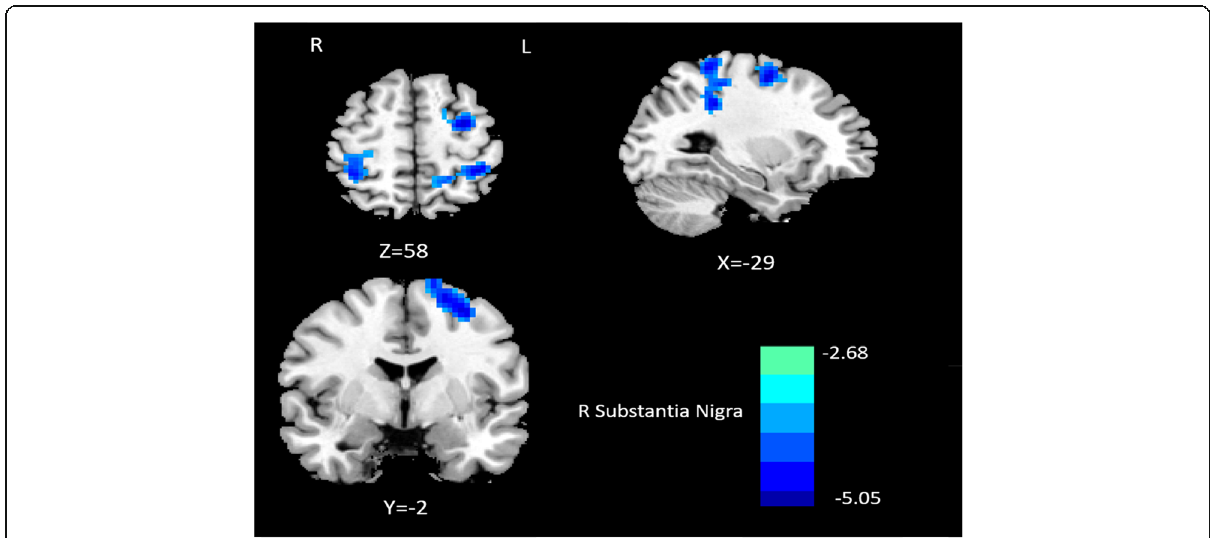
Fig. 2 Altered effective functional connectivity between the right substantia nigra and whole-brain regions in patients with migraine without aura compared with healthy controls. Blue signifies decreased functional connectivity